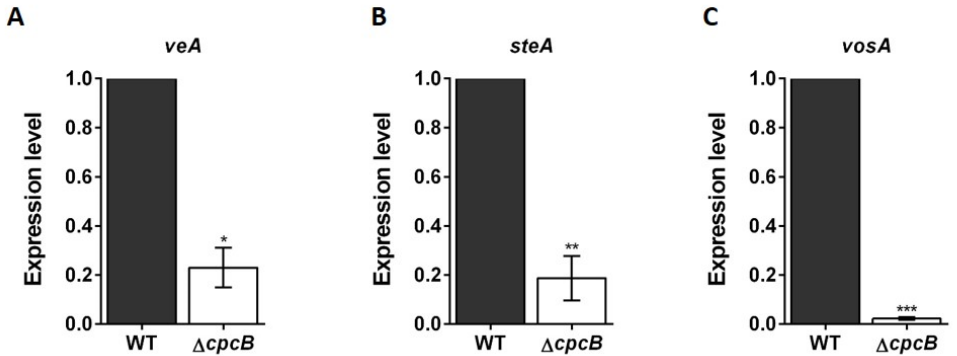
Figure 3. Expression pattern of the genes associated with sexual development, veA ( A ), steA ( B ), and vosA ( C ) genes, in cleistothecia ( n = 4). In 14-day cultures containing both cleistothecia and conidia, a cleistothecium was collected and rolled onto a new agar plate using a stereomicroscope. The cleis-